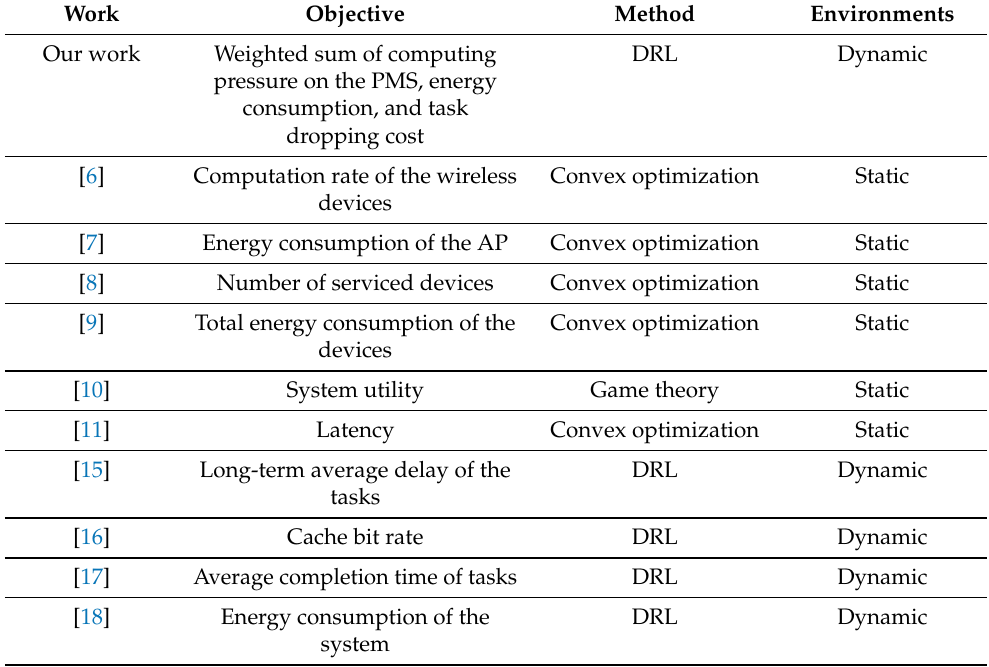
Table 1. Comparison of relevant